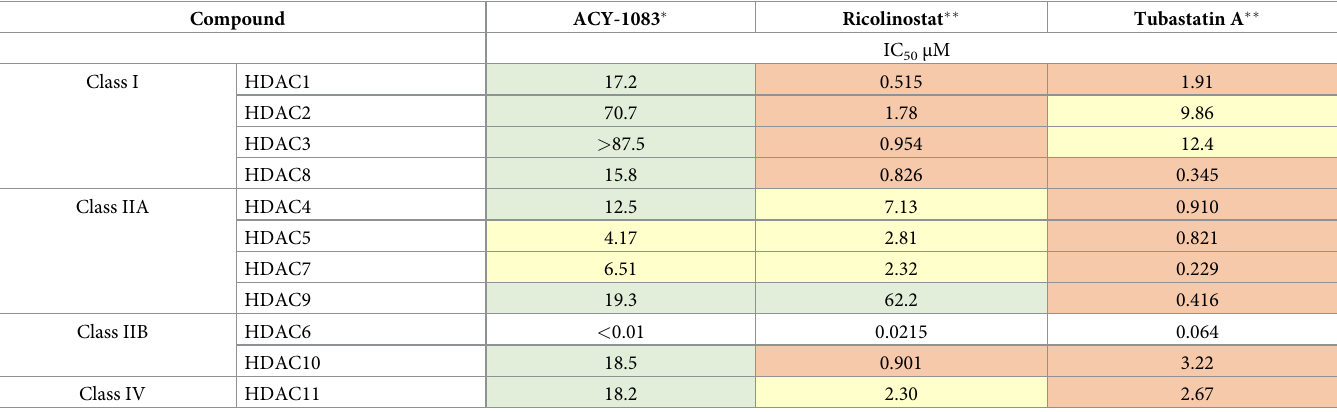
Demonstrating μ M potencies for the different subtypes, color-coded for margins to HDAC6 ( < 100 fold = red, 100–1000 fold = yellow, > 1000 fold = green), � mean of two separate measurements �� one